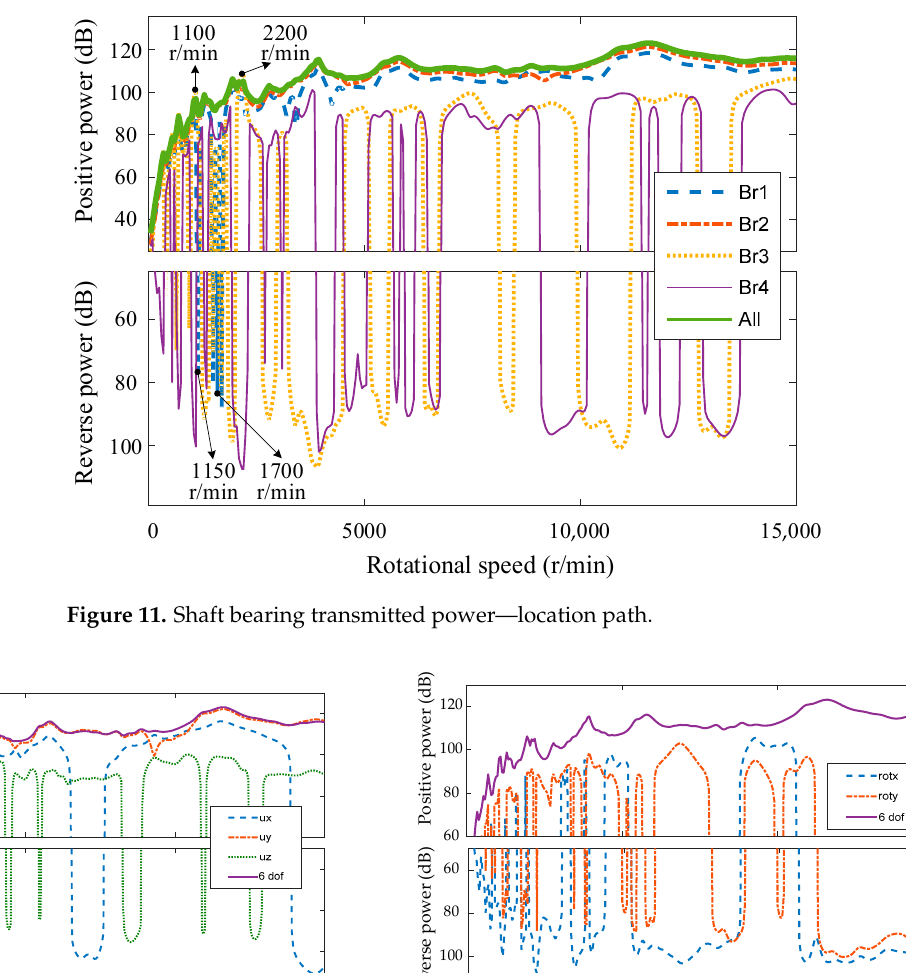
Figure 12. Shaft bearing transmi tt ed power—direction path.